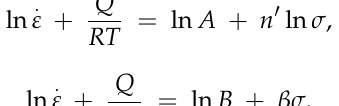
Figure 3. Calculation of the value of ( a ) n (cid:48) by plotting ln σ vs. ln values correspond to strain